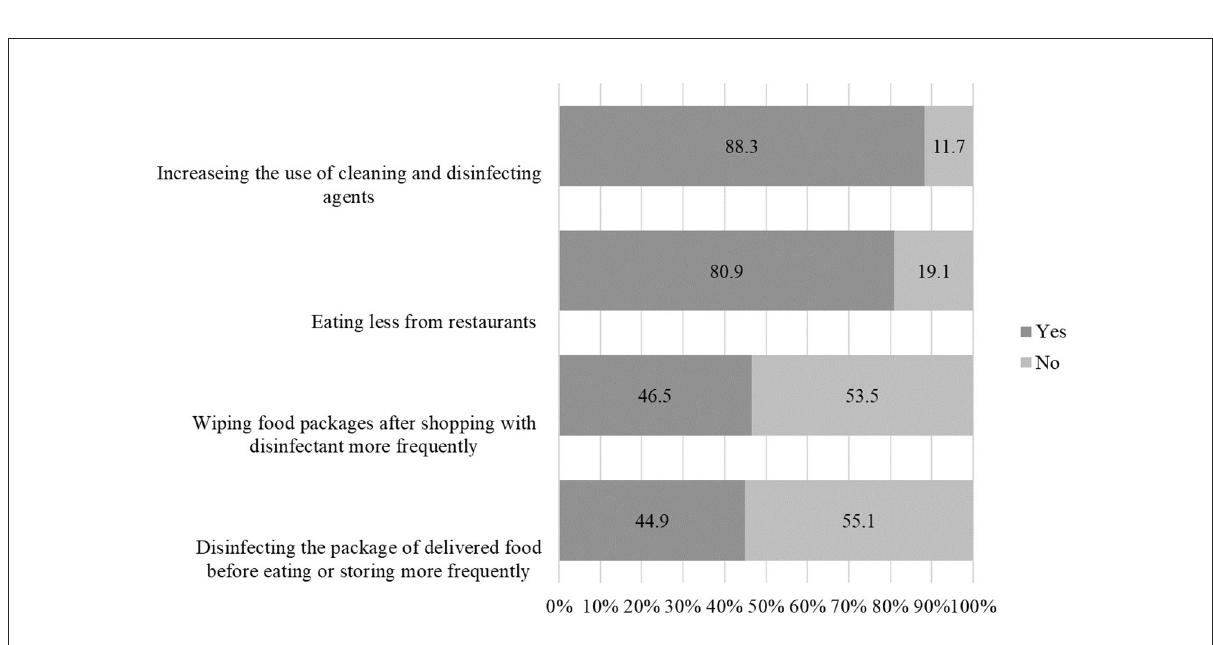
FIGURE4 Practices during the COVID-19 ( n =